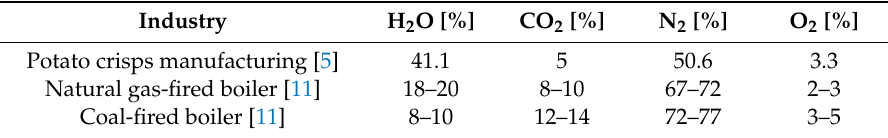
Table 1. Composition of di ff erent industrial flue